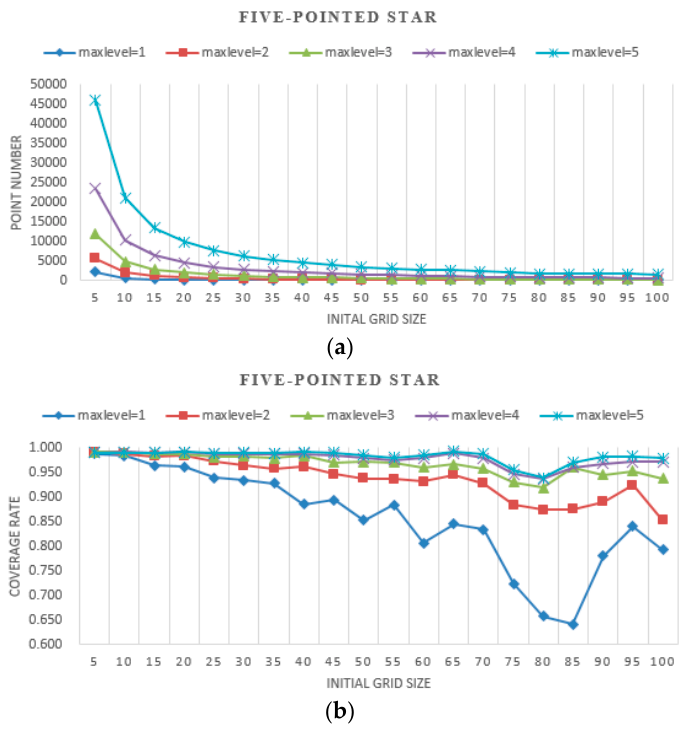
Figure 10. Results for the five-pointed star with different initial grid sizes and max levels. ( a ) point number; ( b ) coverage rate. number; ( b ) coverage